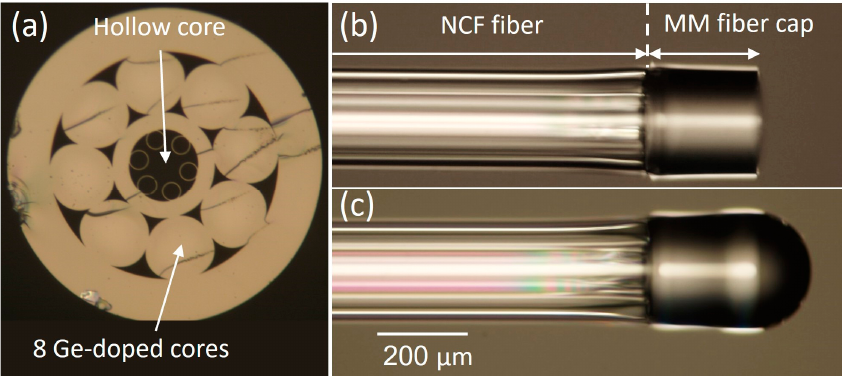
Figure 1. ( a ) The cross section of the NCF (the outer diameter of the fibre is 210 µm); ( b ) NCF probe with cleaved MM fibre; ( c ) NCF probe with spherical micro-lens. with cleaved MM fibre; ( c ) NCF probe with spherical